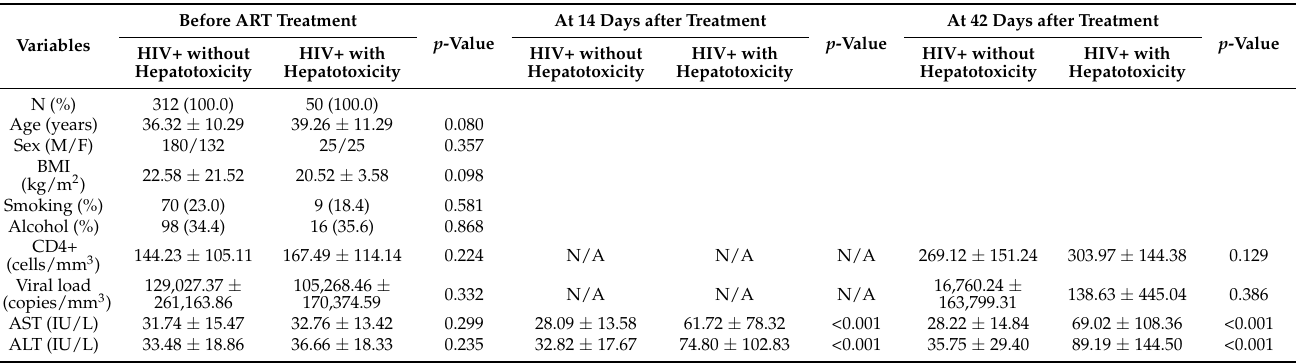
Table 1. Clinical characteristics of HIV patients with and without ARVDILI.